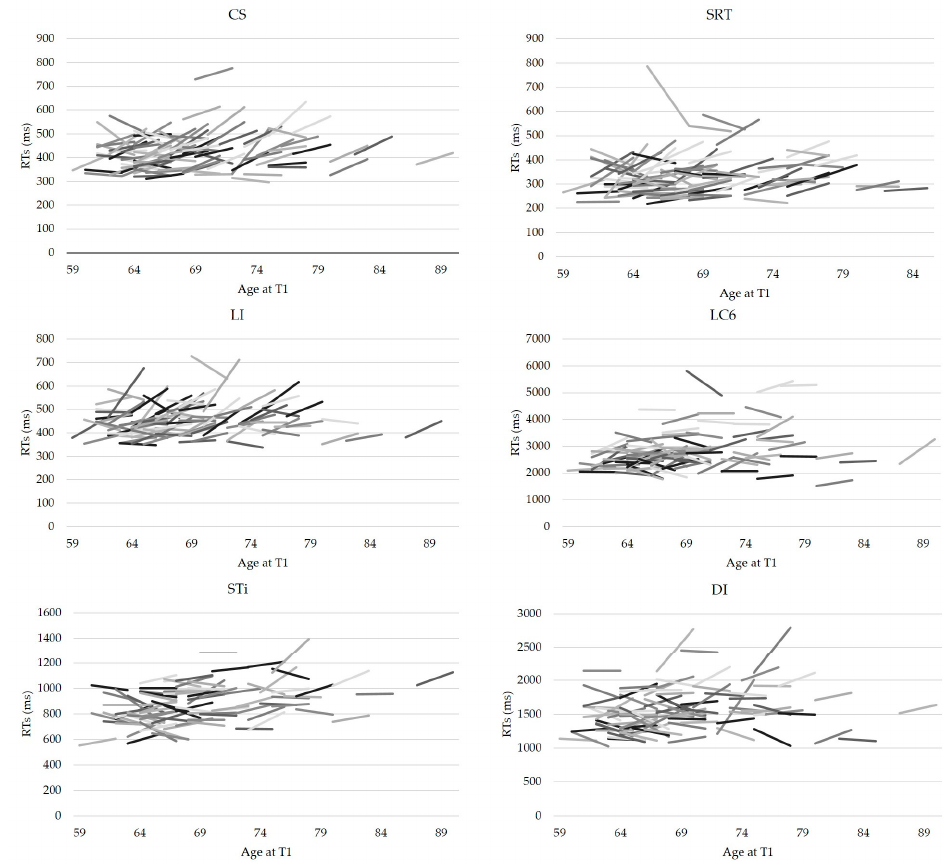
Figure 2. Intraindividual change by Age and Condition (six conditions out of nine). Each segment represents performance of a given individual at baseline and at the fourth experimental wave. Age is indicated at performance at baseline; each segment corresponds to approximately 7–8 years.